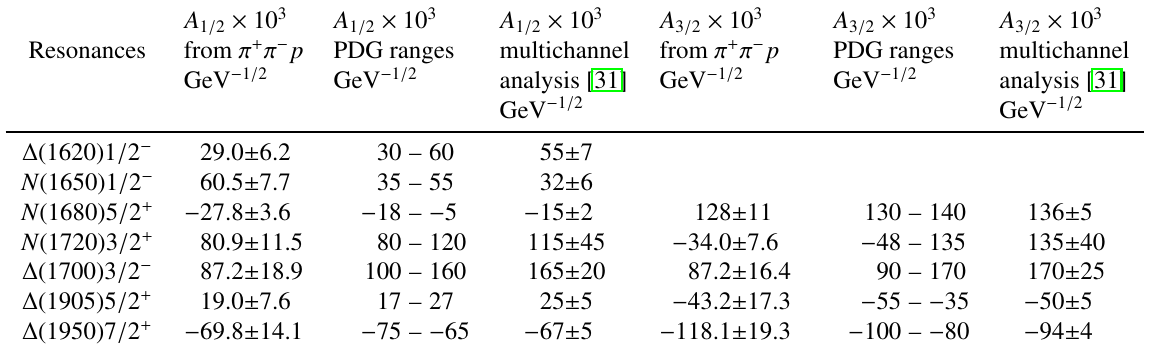
Table 3. Resonance photocouplings determined from analysis of the π + π − p photoproduction data from this work in comparison with the previous results from the PDG average [29] and from multichannel analysis